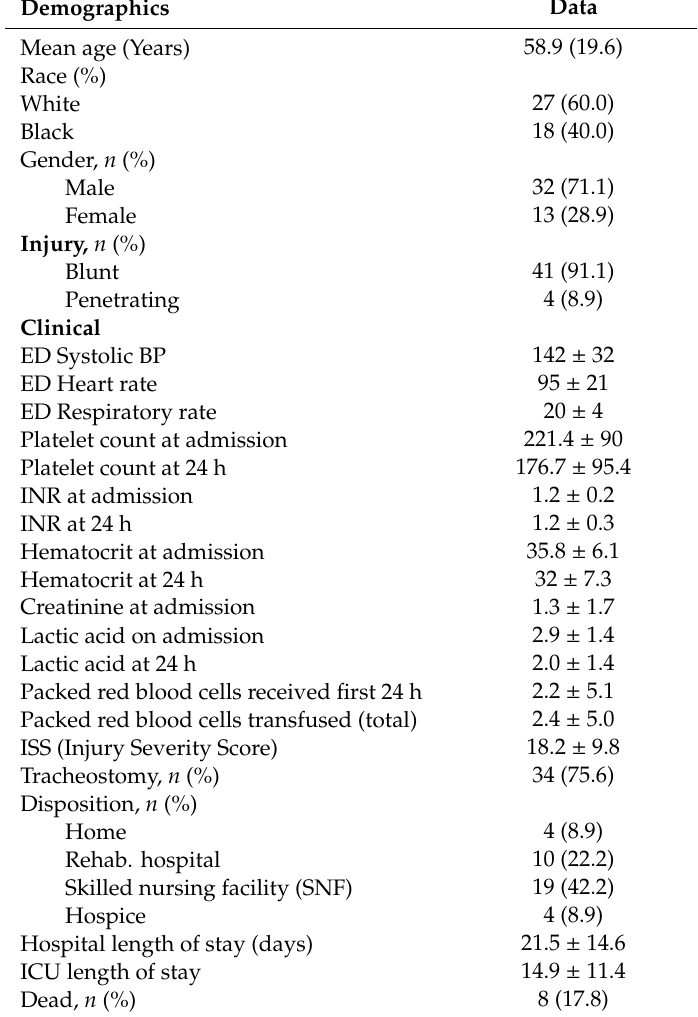
Table 1. Demographic, injury, and clinical characteristics of all trauma patients (male and female) with ventilator-associated pneumonia (VAP), N = 45.